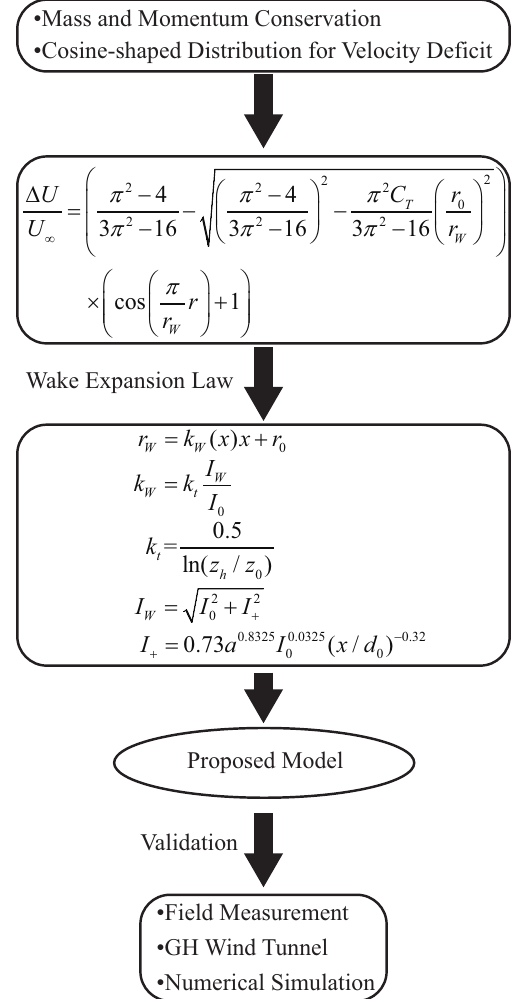
Figure 5. A flowchart of development and validation of the proposed